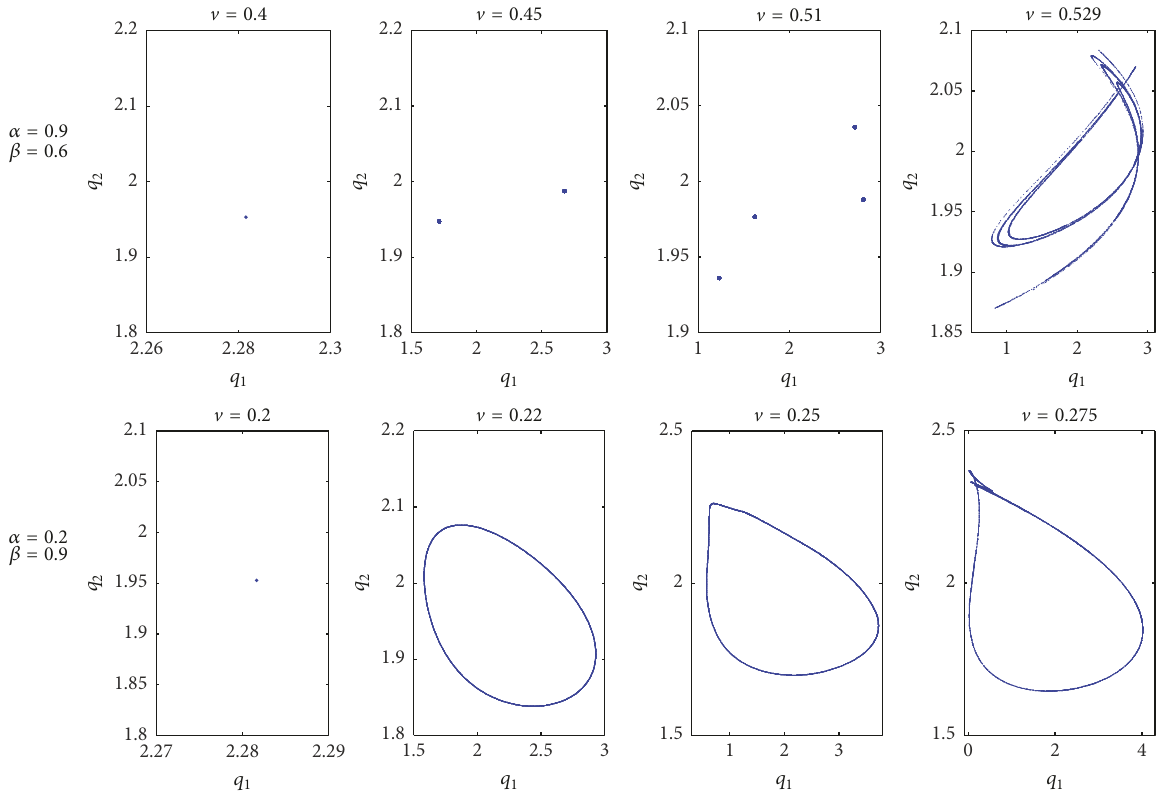
Figure 5: Phase portrait for Figure 1 with various 𝛼,𝛽 , and V